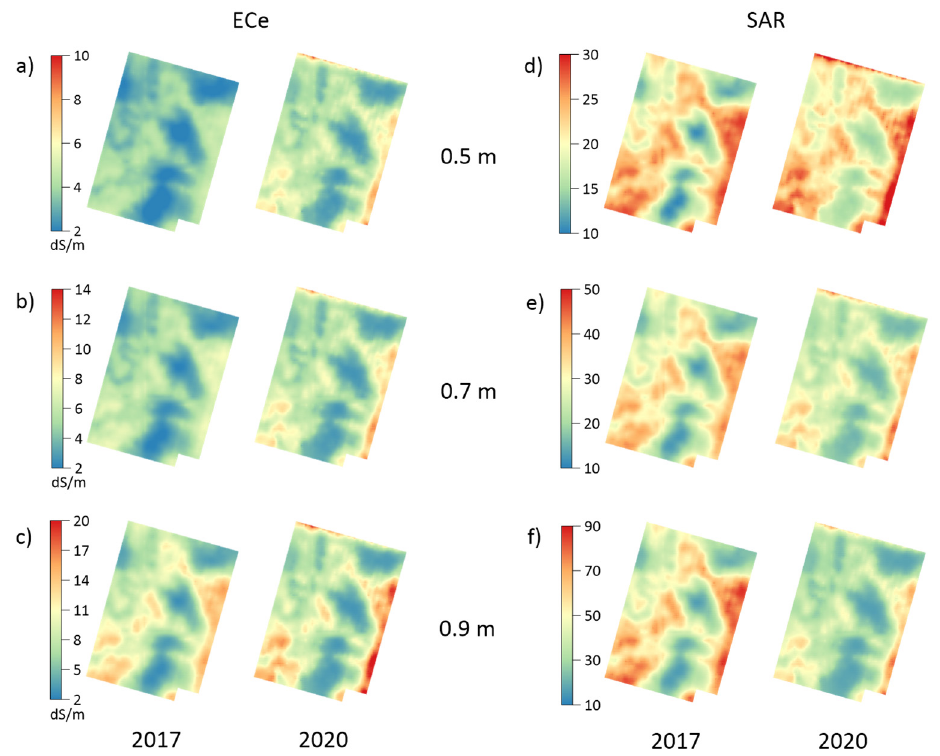
Figure 9. ECe ( a – c ), and SAR ( d – f ) for 2017 and 2020 at depths of 0.5, 0.7 and 0.9 m.